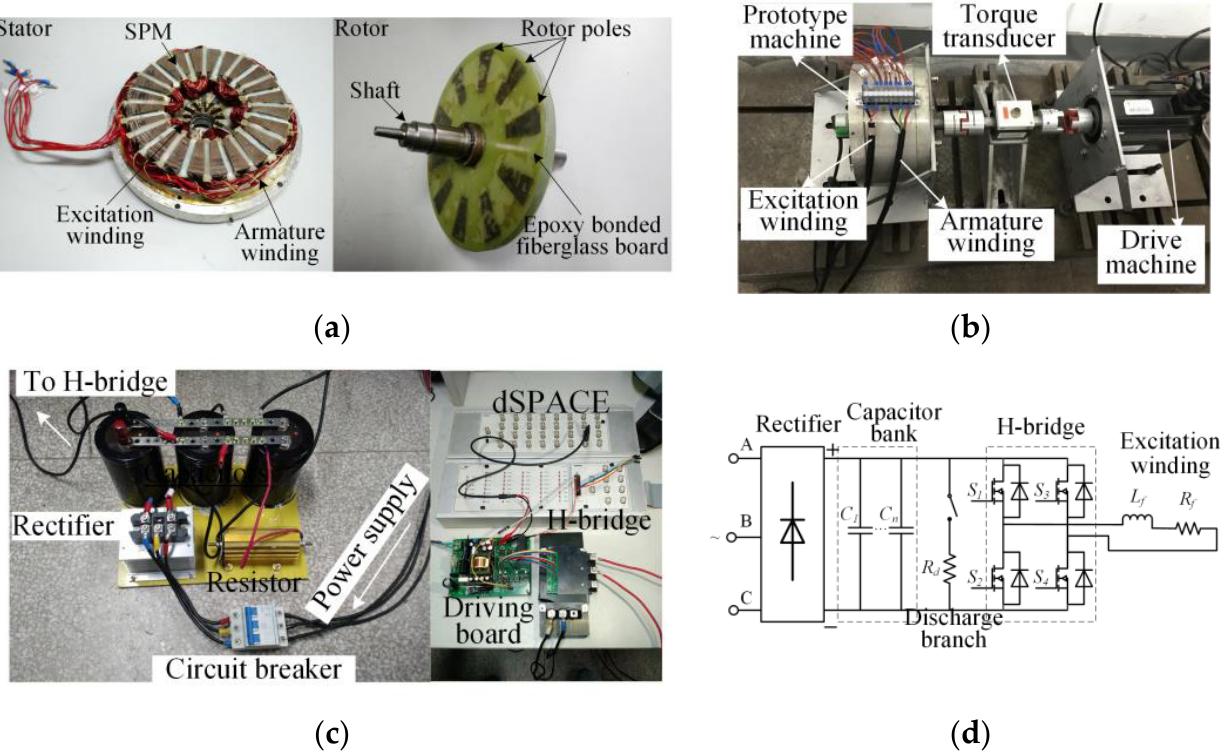
Figure 18. SPM-AFSM machine prototype and the experimental setup: ( a ) stator and rotor; ( b ) experimental setup; ( c ) bidirectional capacitive-discharger magnetizer; ( d ) schematic of the magnet- izer.